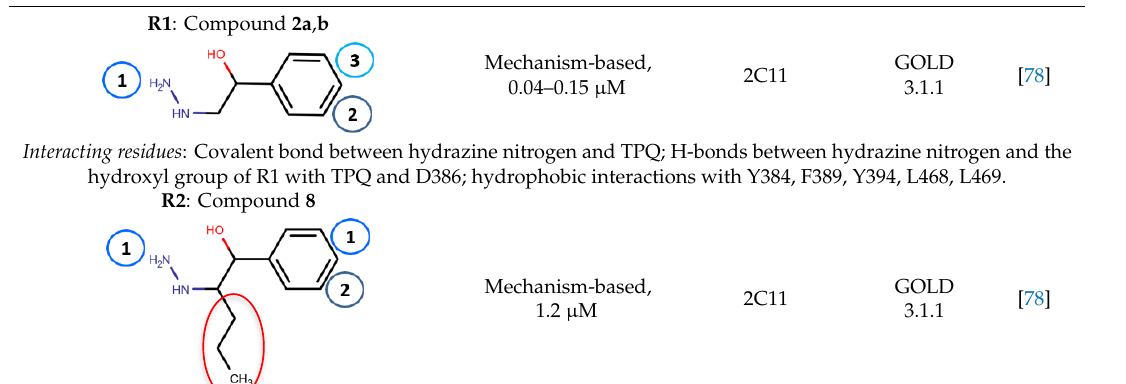
Table 2. List of computational studies modeling the interactions between various inhibitors and hVAP-1. Used Docking Inhibitor Type of Inhibitor, IC50 VAP-1 Ref. Tool Inhibitor Structure Hydrazine